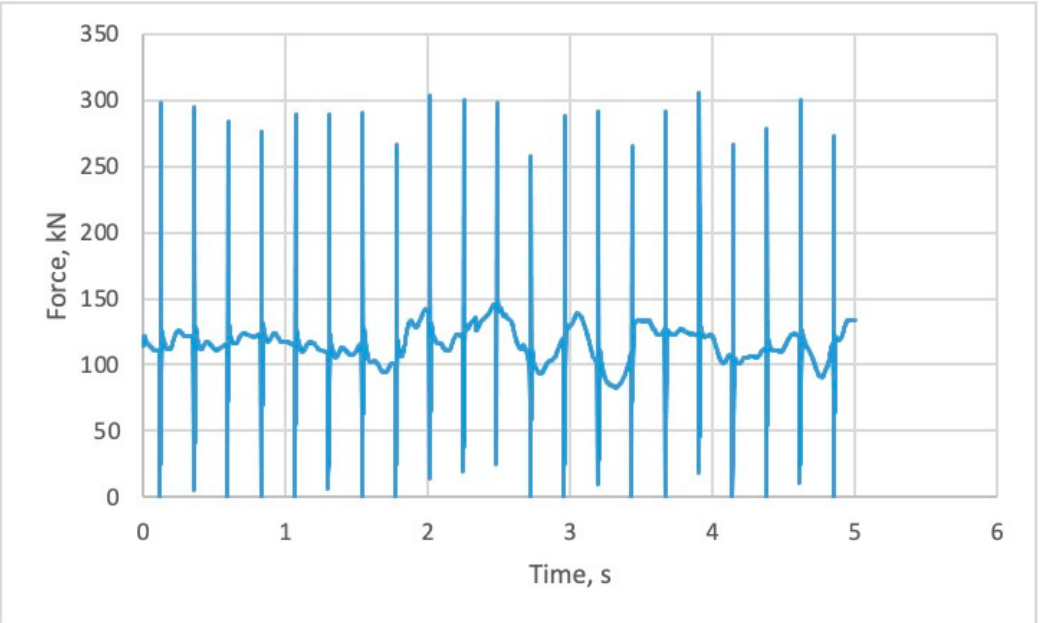
Figure 11. Calculated force values of the 85th wheelset.